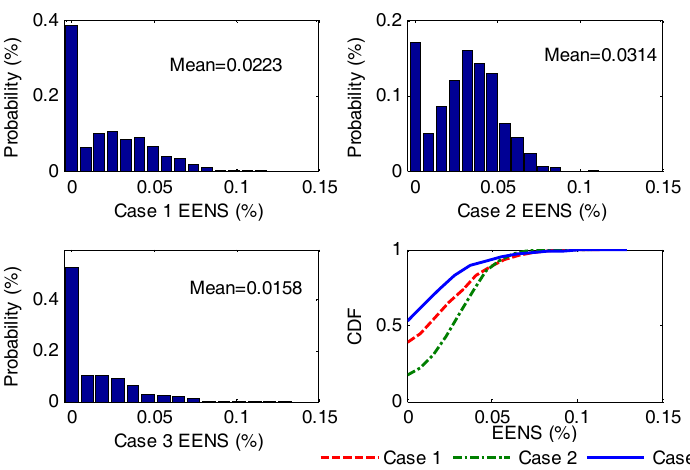
Figure 5. Probability distributions of expected energy not supplied (EENS) and CDF for cases 1–3 with 100 MW wind power penetration. Table 2. Result comparison for cases 1–3 with 50 MW wind power.